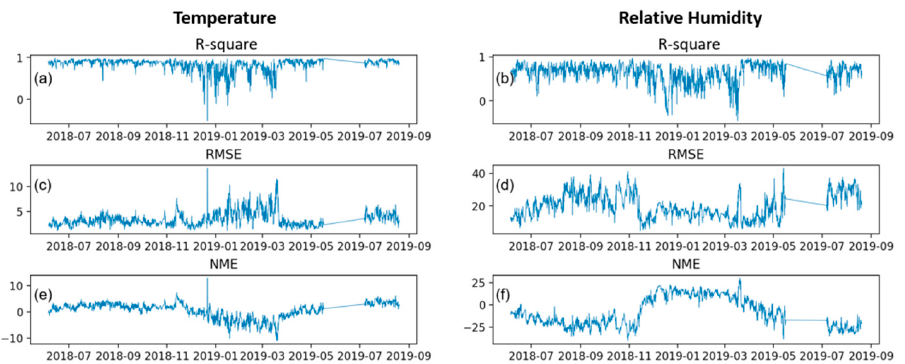
Figure 4. Forecast performance over time at station 51359: panels ( a , c , e ) are, respectively, referring to the R-square, RMSE, and NME values of temperature. The panels ( b , d , f ) are the metric values of relative humidity. The x -axis refers to observation time.